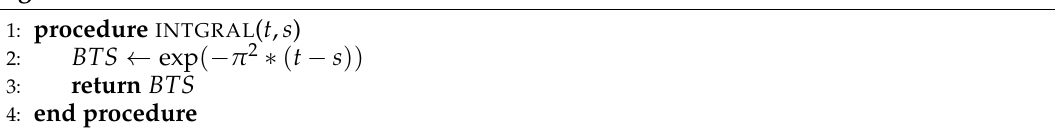
Algorithm 5 Coefficient function in the